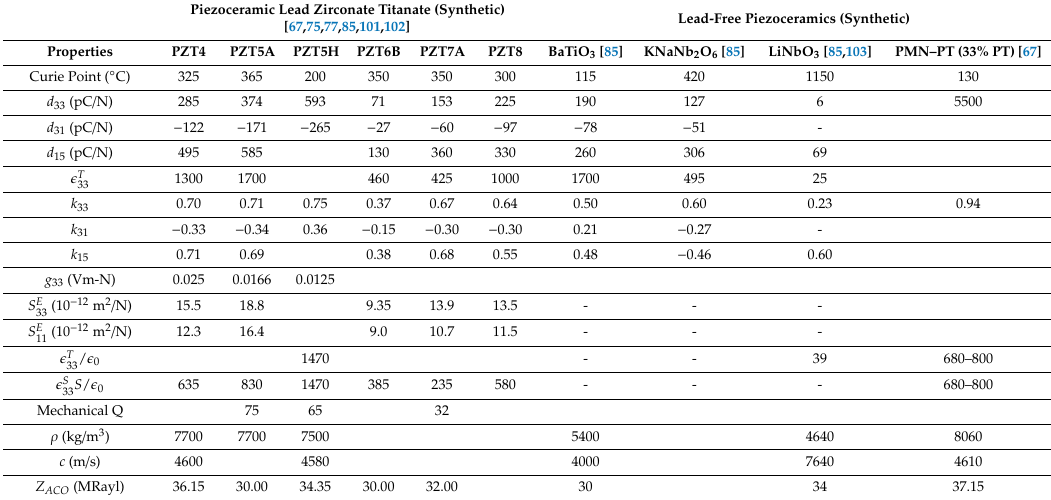
Table 1. Electric and acoustic properties of commonly used bulk piezoceramic materials for transducer applications. PMN–PT: lead magnesium niobate-lead titanate, PZT: lead zirconate titanate.